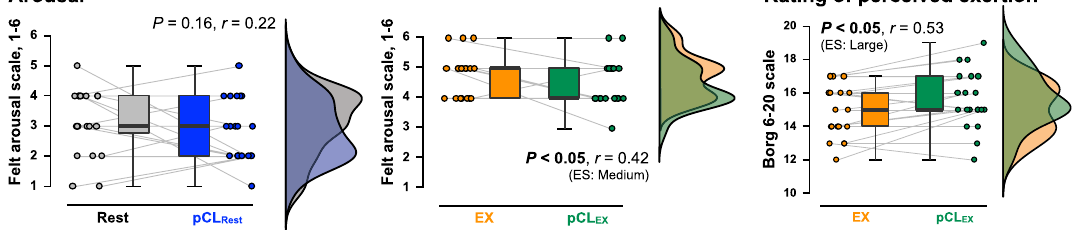
Figure 2. The arousal and rating of perceived exertion (RPE). Raincloud plots showing the distribution of arousal and RPE. Circle plots represent individual data, and box-and-whisker plots are median (IQR and max/ min).